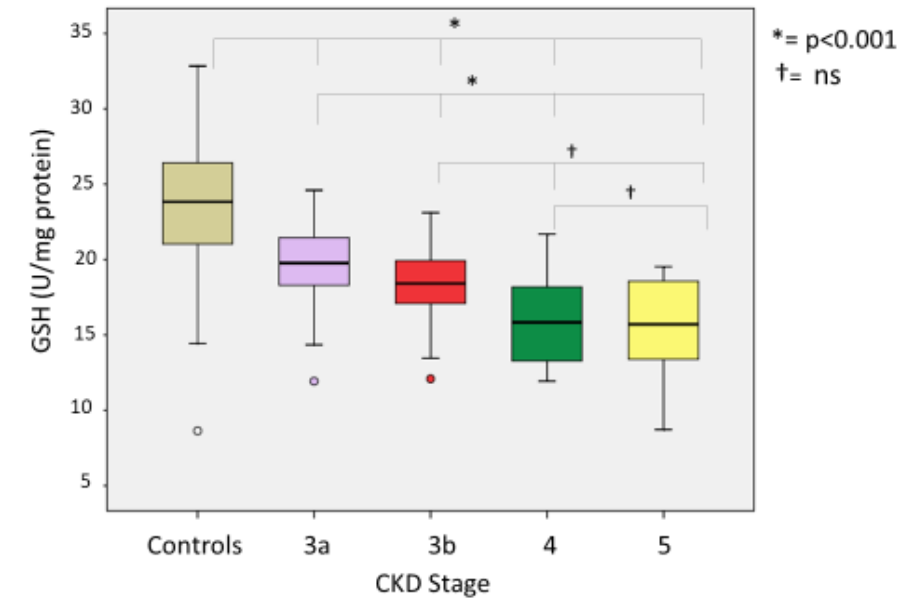
Figure 5. GSH in different stages of CKD.